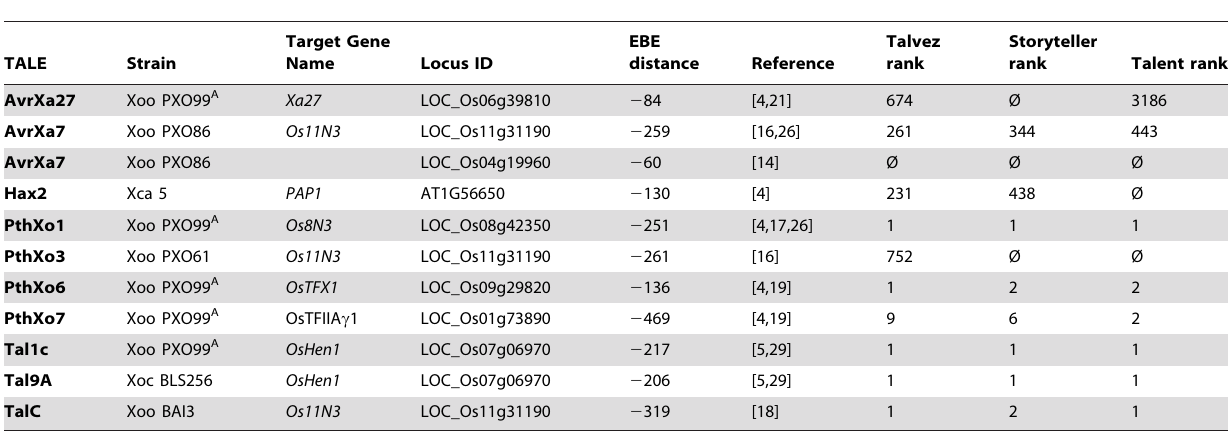
Table 1. Comparison of EBE predictors rankings of known TALE targets in genomic